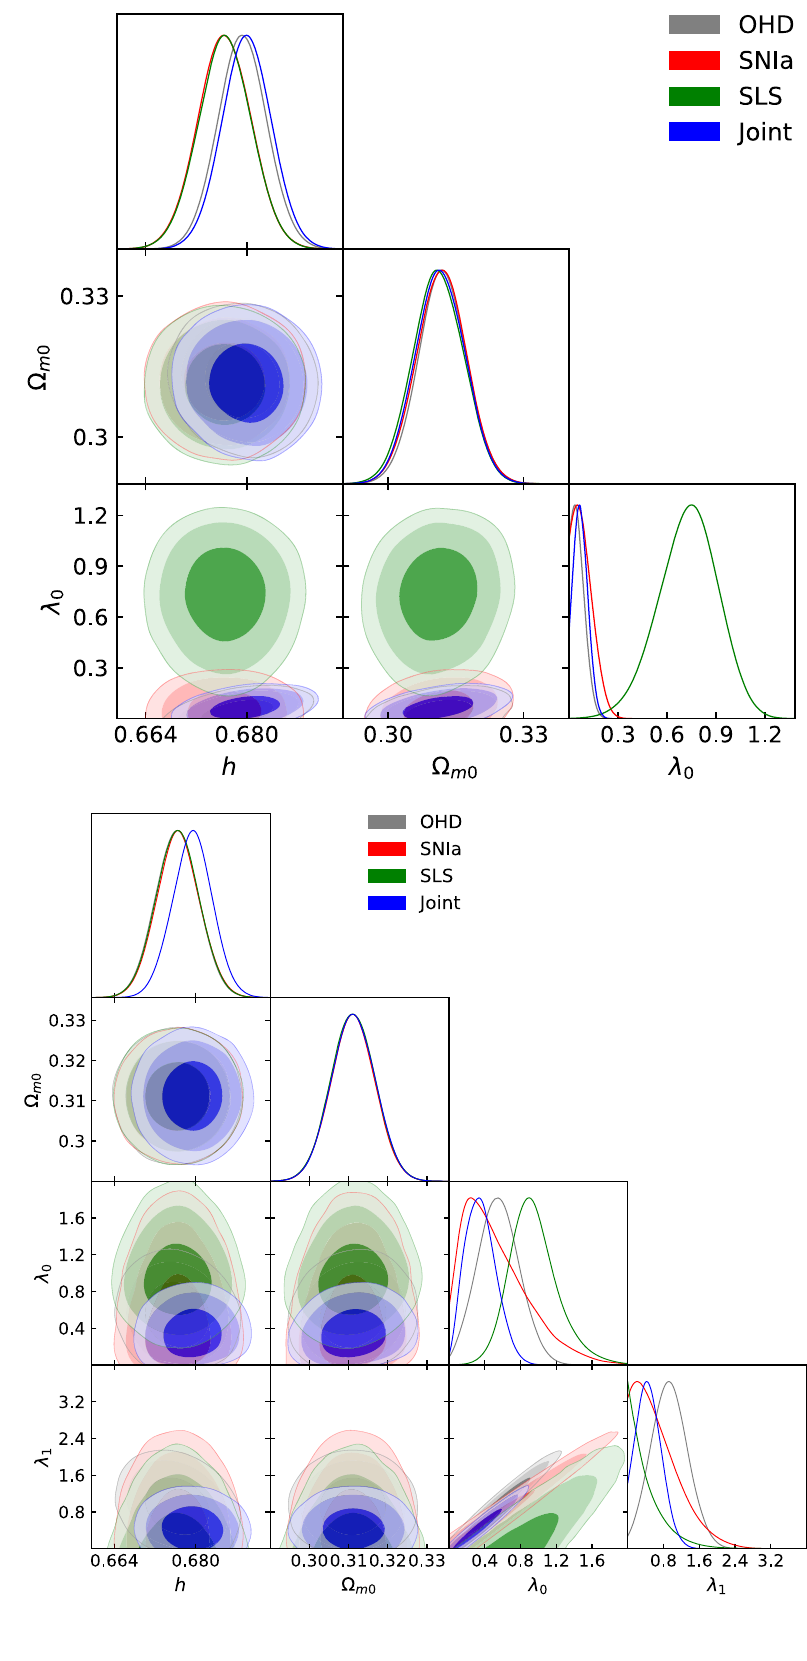
Fig. 1 2D contour and 1D posterior distribution of the free parameters for the two fluids model when the viscosity coefficient is a constant (top panel) and polynomial (bottom panel) using the OHD, SNIa, SLS and OHD+SNIa+SLS (joint)